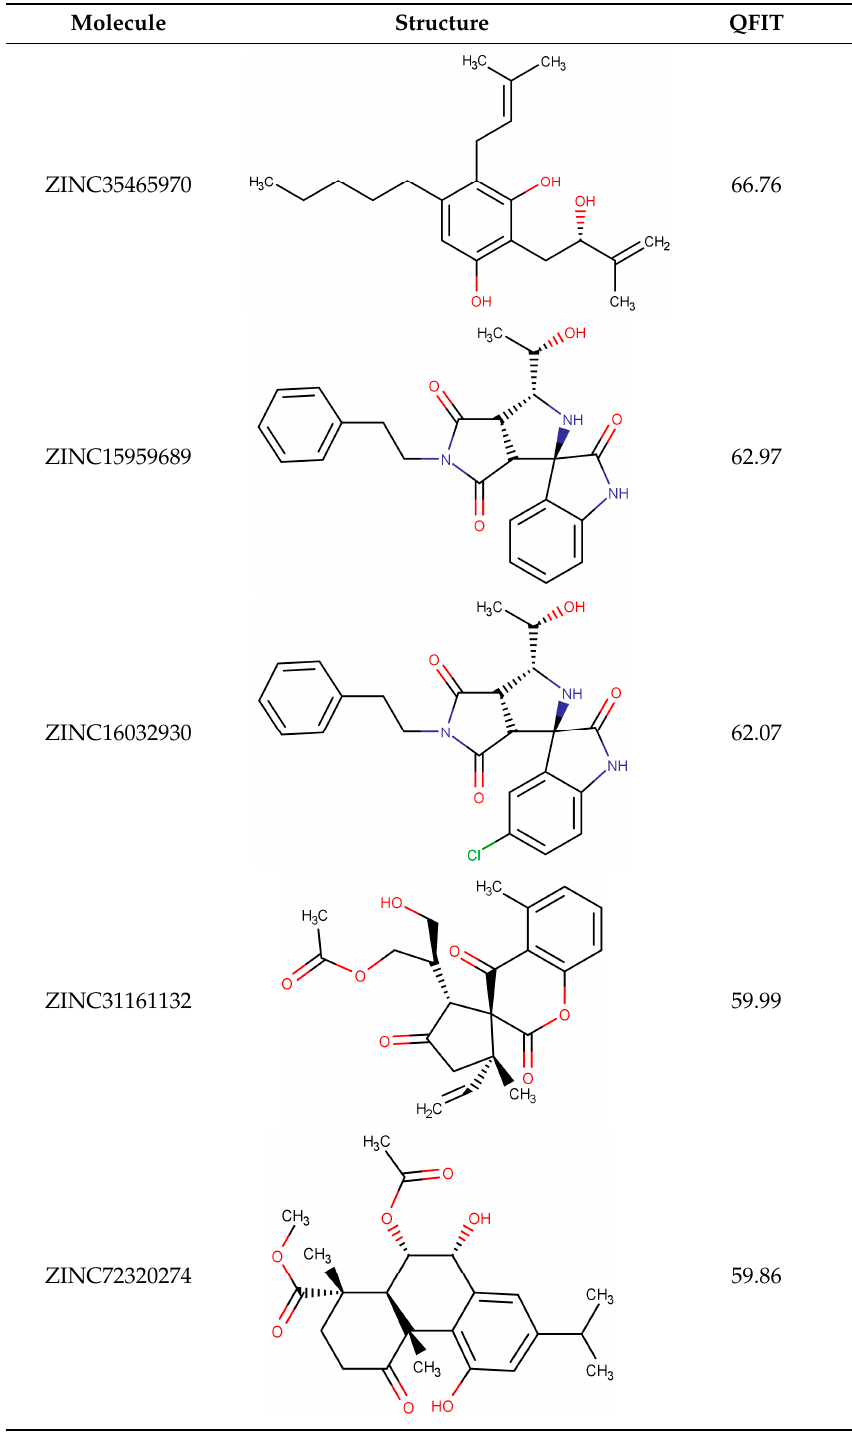
Table 2 . The five molecules with the best QFIT value.